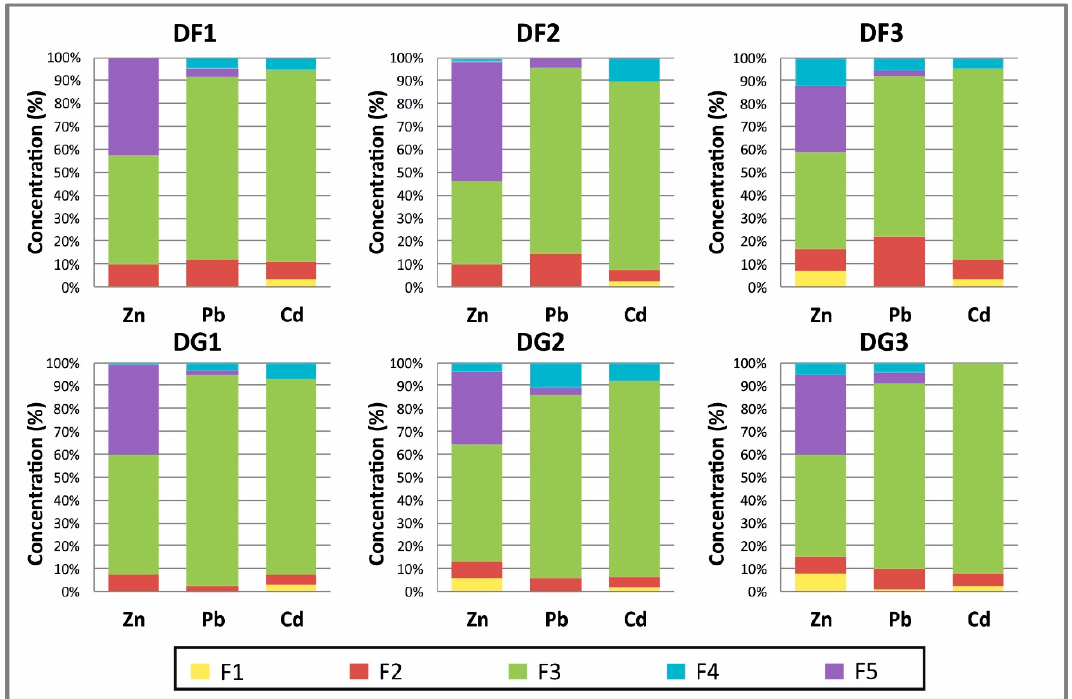
Figure 2. Proportions of the fractions upon sequential extraction of the tailing samples (DF-DG). DF—fine-grained residues; DG—coarse-grained residues; F—fractions extracted (F1, F2, F3, F4 and F5)